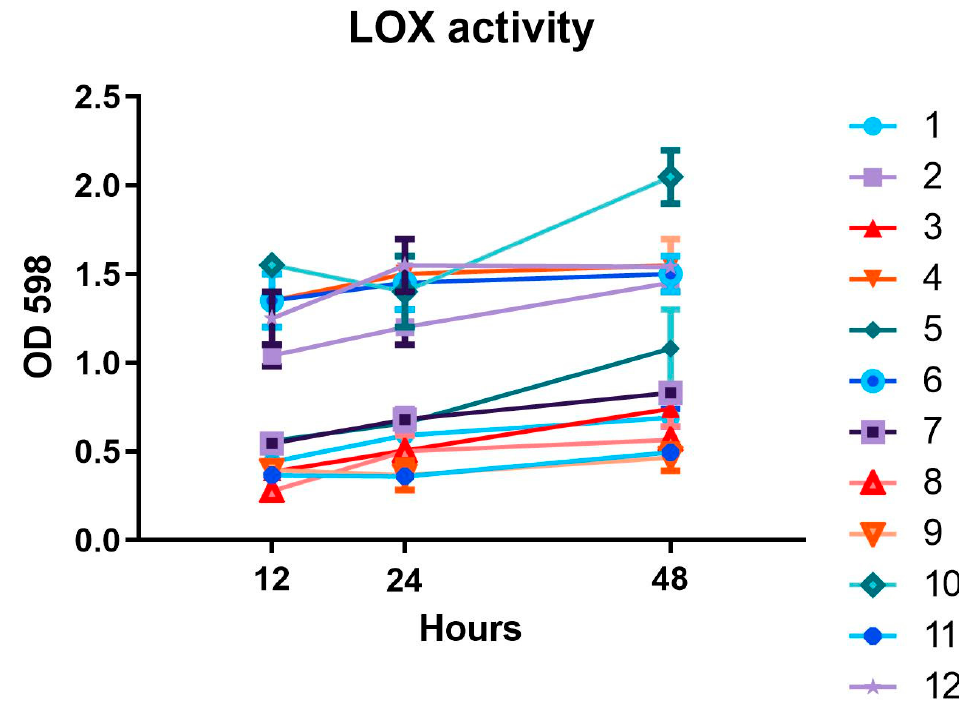
Figure 2. Lipoxygenase (LOX) activity of the 12 selected P. aeruginosa strains. LOX activity was evaluated at 12, 24, and 48 h. Each colored line (numbers from 1 to 12, see Table 1) refers to a different P. aeruginosa strain.